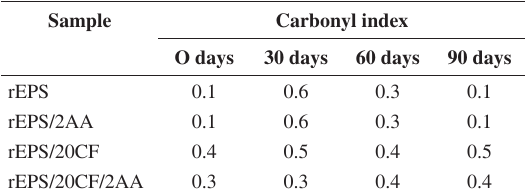
Table 2. Carbonyl index of the samples before and after 30, 60 and 90 days of exposure in the simulated